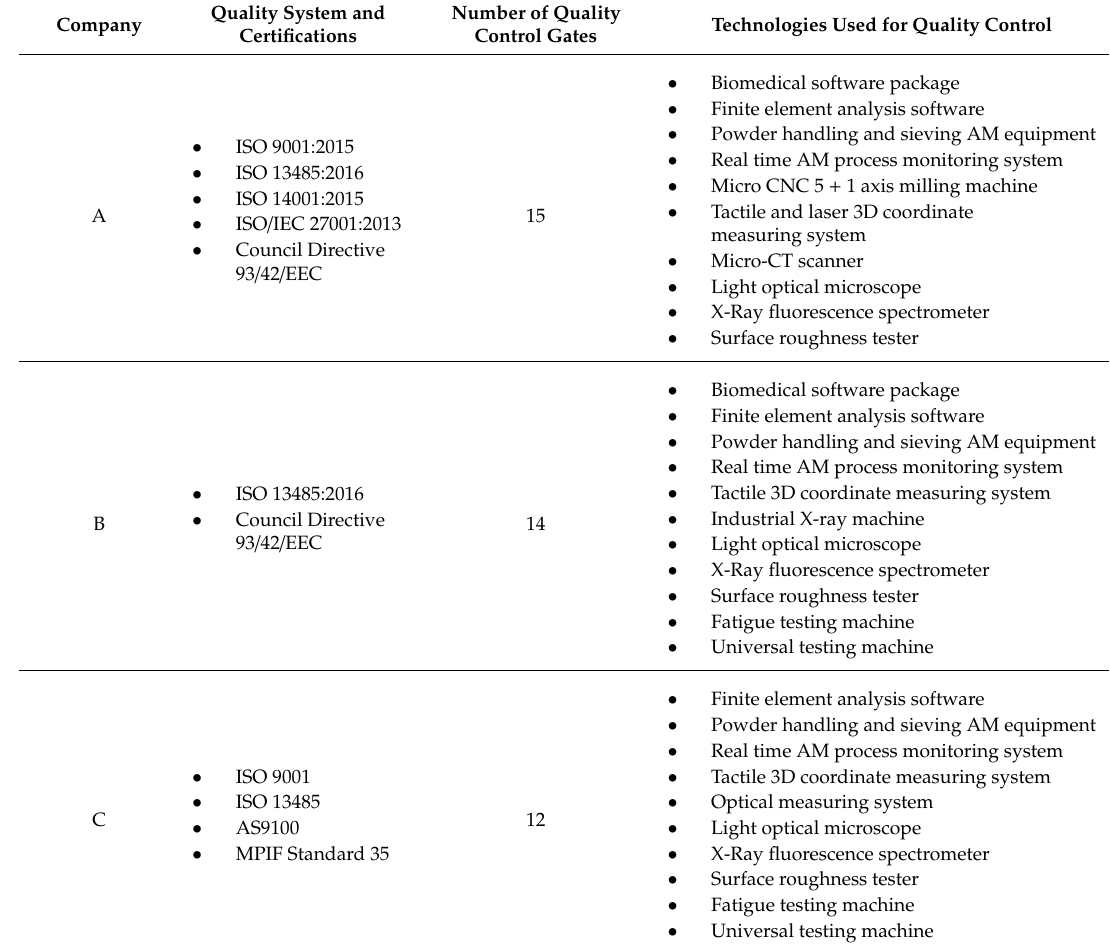
Quality management systems, control gates, and technologies used by the three studied